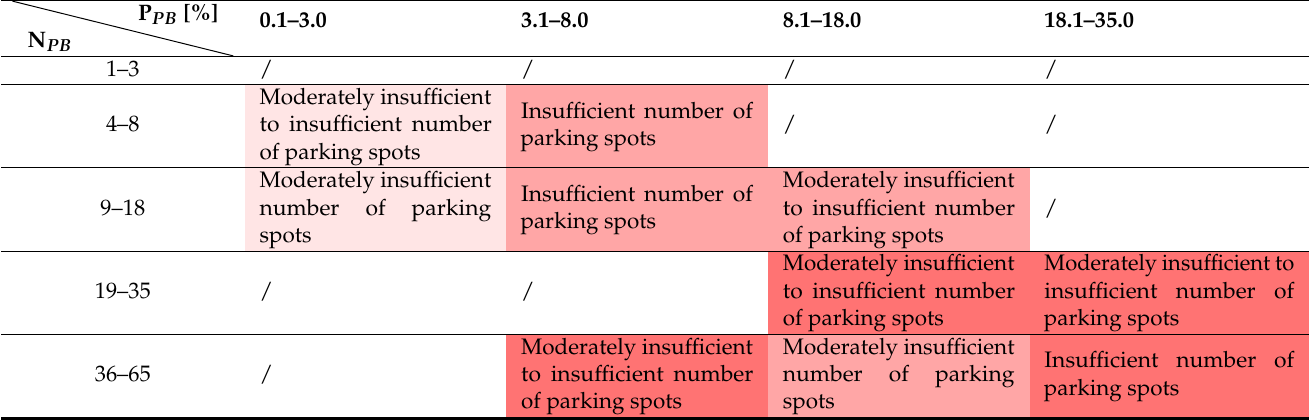
Table 5. Final designation of importance to 100 × 100 m grid cells in Dresden (marked in shades of red): low (red 10%), moderate (red 35%), and high importance (red 55%). The designation of importance is based on detected sufficiency of parking spots (this table) and assigned relevance (Table 2). N